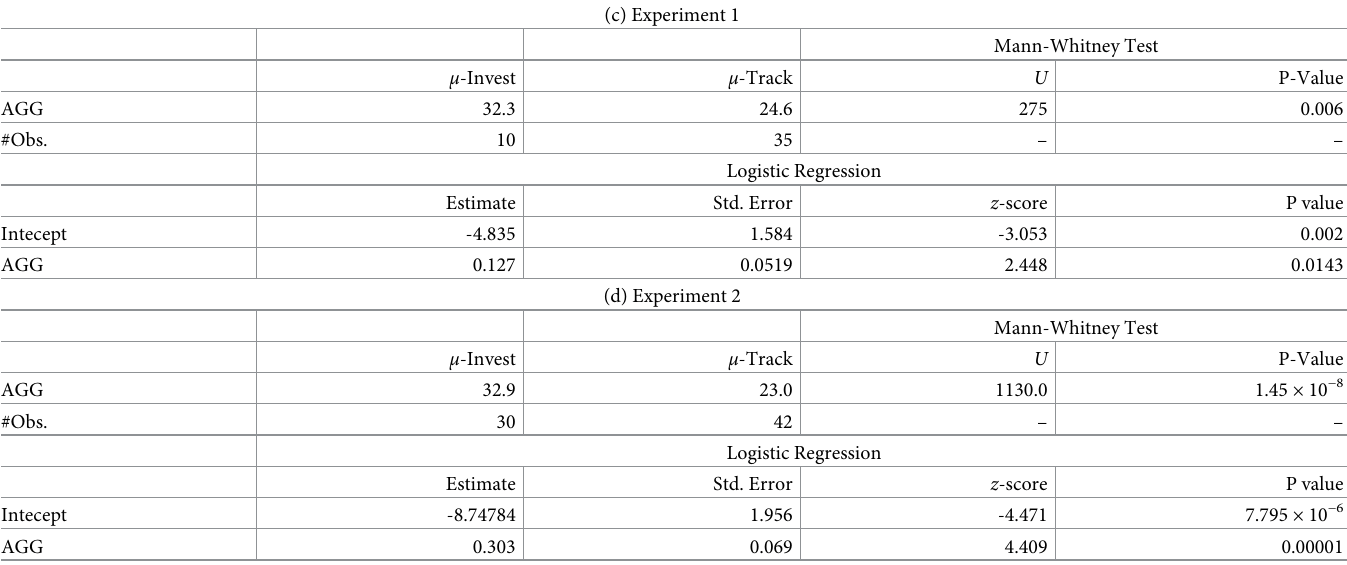
Table 5. Effect of aggression in the baseline treatment. The table presents the results of the non-parametric Mann-Whitney test of the null hypothesis that the median aggression scores of tracking and non-tracking subjects are equal as well as a univariate logistic regression in which the dependent variable is the decision between tracking and investing and the independent variable is the aggression